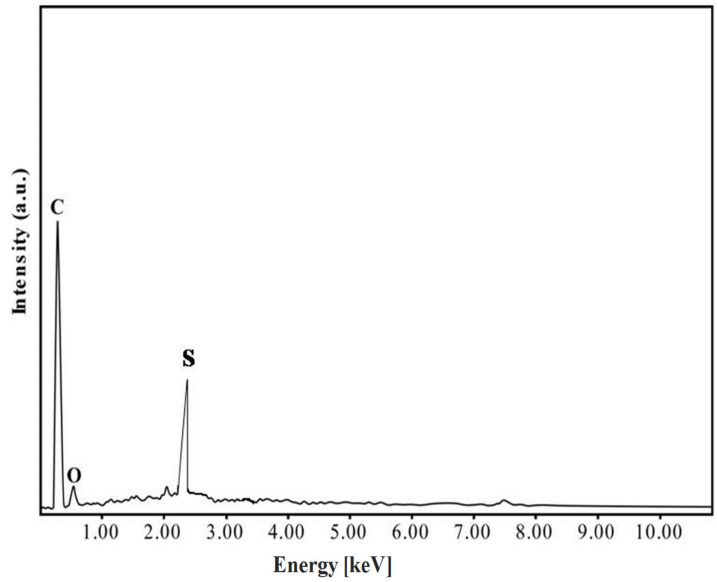
Figure 5. EDAX image of the TPC-SO 3 H catalyst.